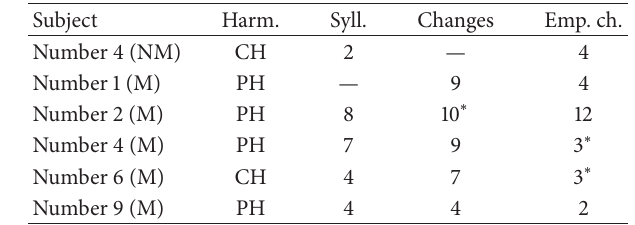
Table10:Tableofanswerstoquestionsaboutthesyllablesofchange, the number of harmonic changes, and the number of employed chords obtained by partially (PH) or complete (CH) successful sub- jects in the harmonization task. The asterisks show the correct